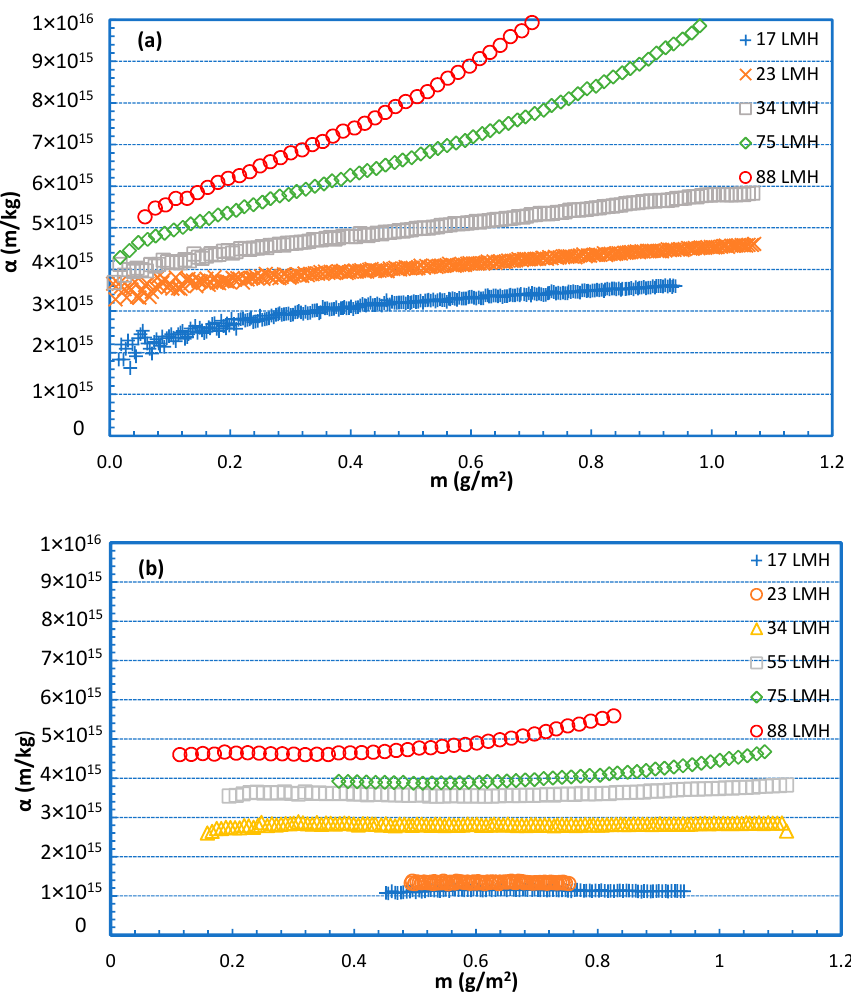
Figure 10. Specific fouling resistance α versus deposited foulant-mass density m. Fouling species: ( a ) 100% SA and ( b ) 100% BSA.